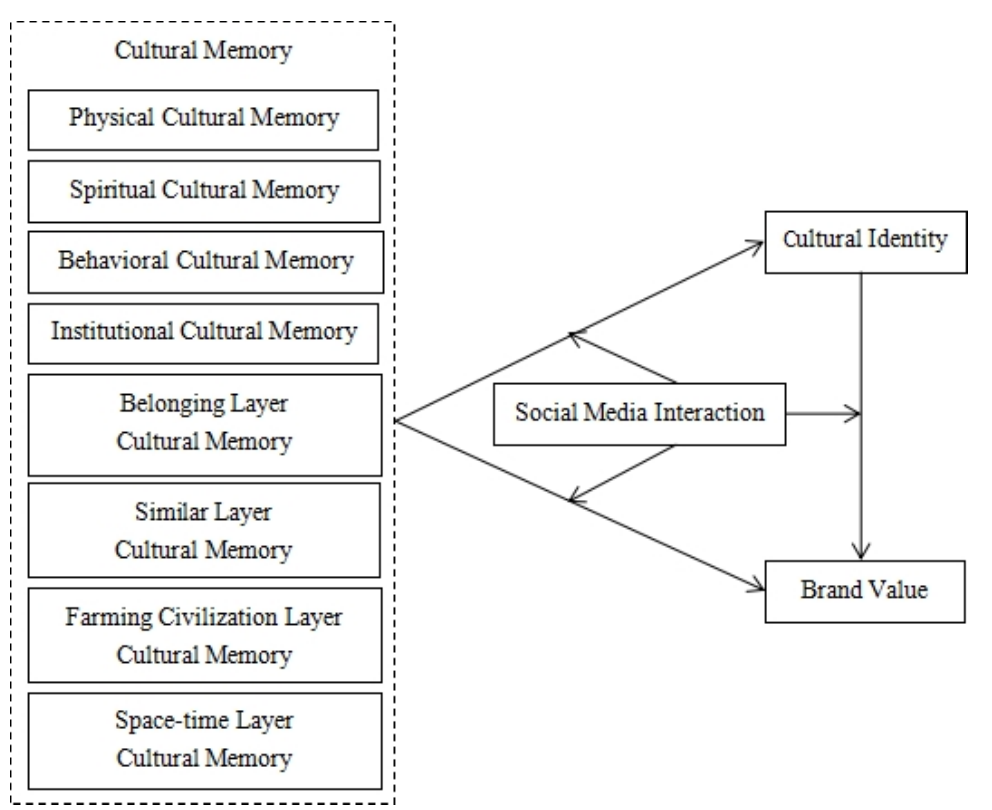
Figure 1. The theoretical model of this study.